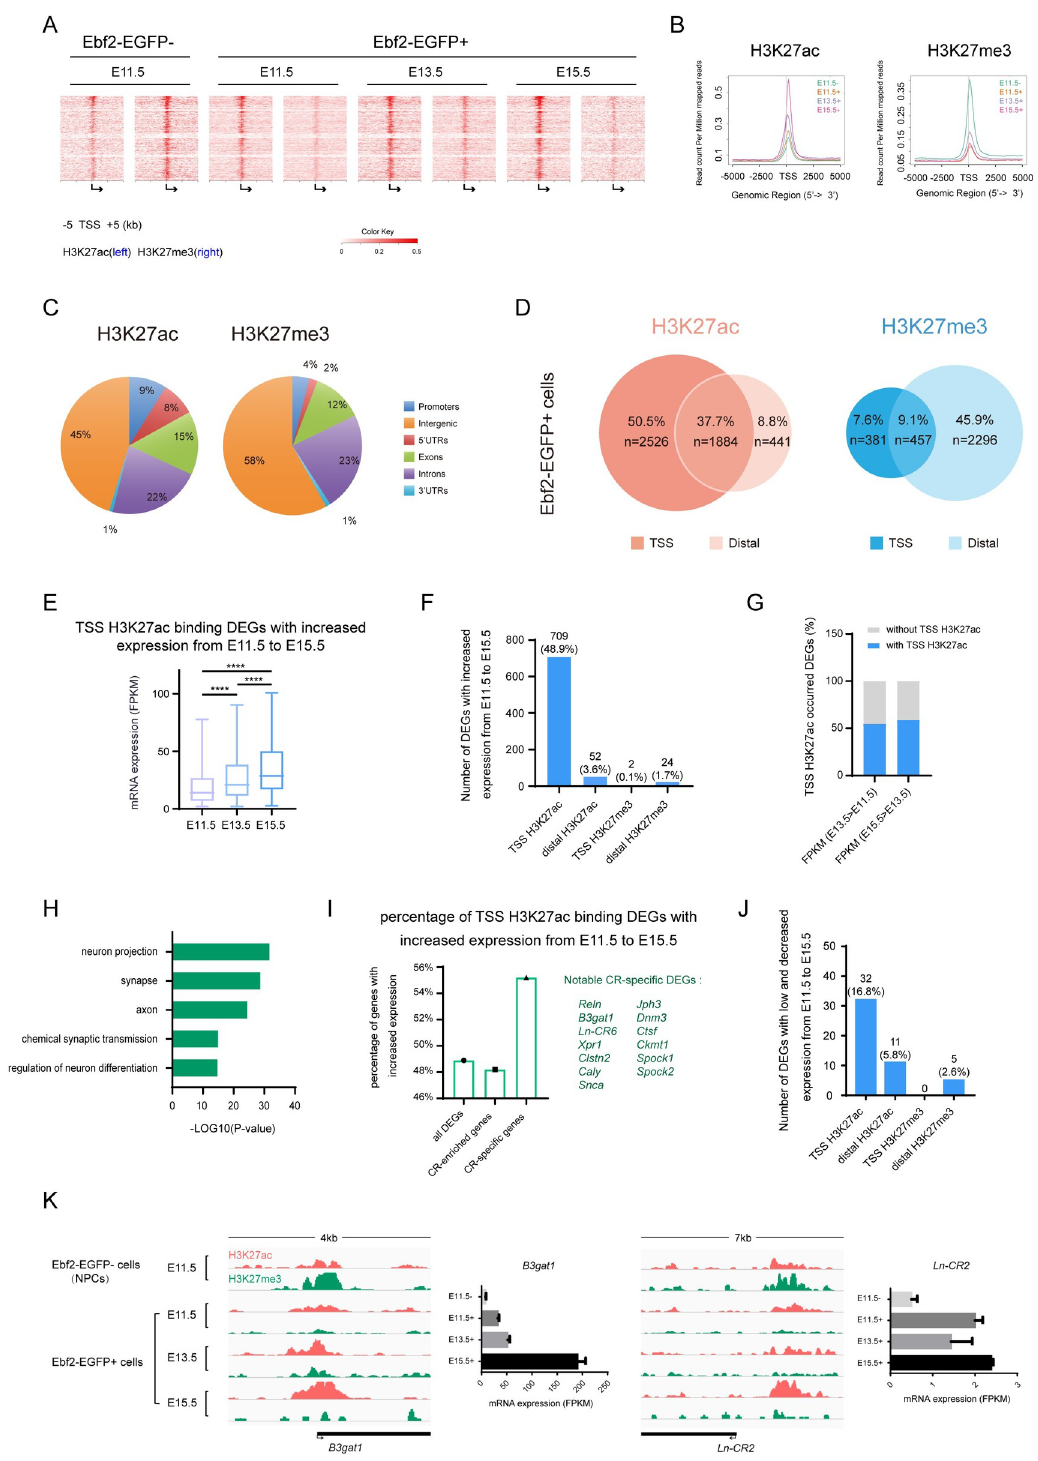
Fig 6. Genomic features of H3K27ac and H3K27me3 histone modification in the early differentiating neurons. (A) Heatmap representation of ChIP-seq signal density for H3K27ac and H3K27me3 for 10 kb centered on predicted gene TSSs in Ebf2-EGFP- cells (E11.5) and Ebf2-EGFP+ cells (E11.5, E13.5 and E15.5), respectively. (B) A profile plot showing normalized H3K27ac (left) or H3K27me3 (right) enrichments around TSS of all detected genes in Ebf2-EGFP- cells (E11.5) and Ebf2-EGFP+ cells (E11.5, E13.5 and E15.5), respectively. (C) Genomic features of H3K27ac and H3K27me3-bound genes in Ebf2-EGFP+ cells.